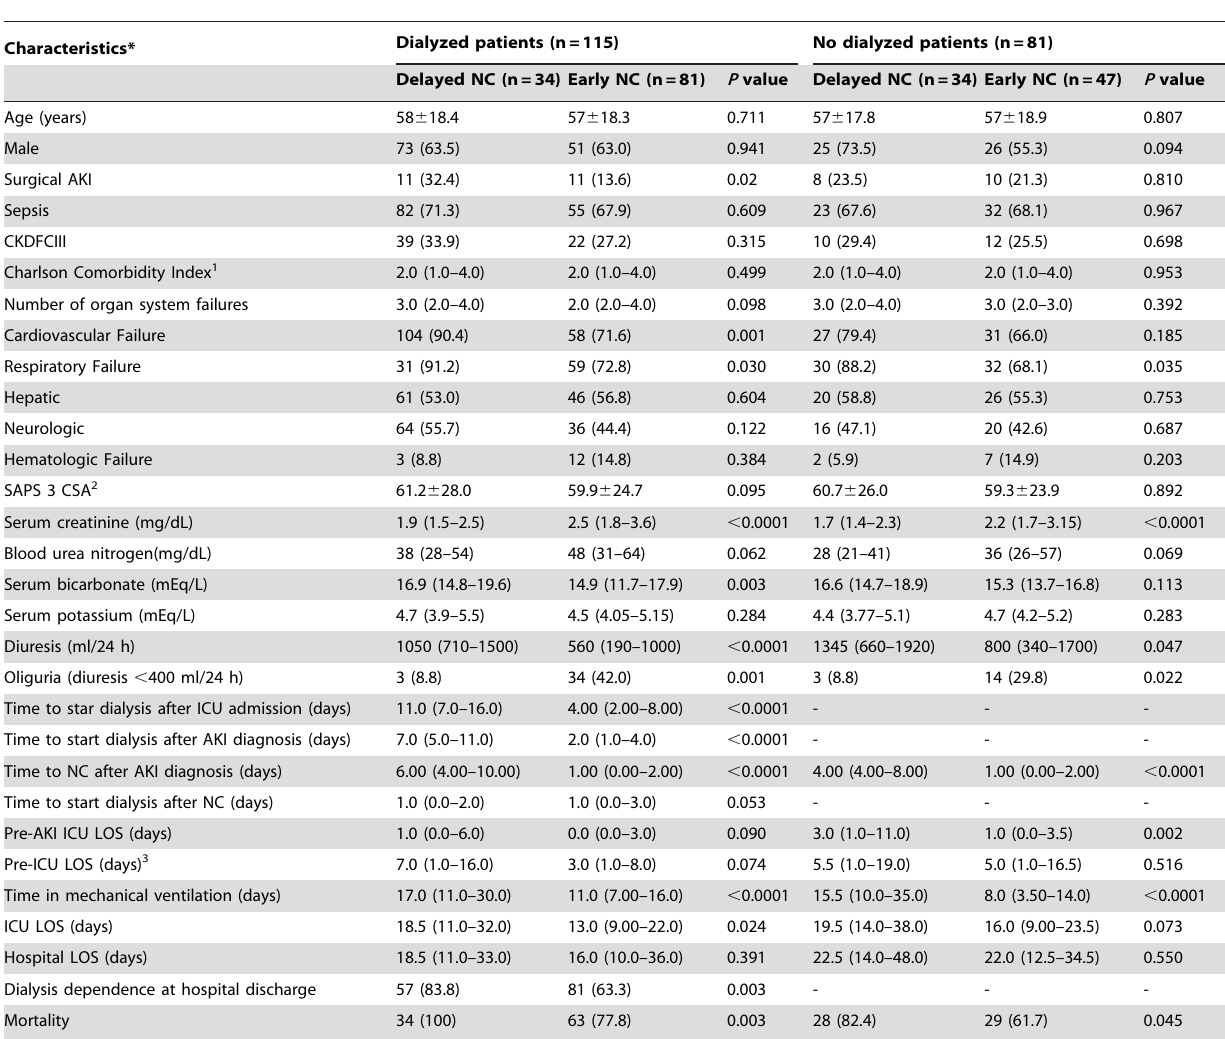
Table 5. Patients characteristics comparing delayed and early Nephrology Consultation (NC) subgroups in both dialyzed and no dialyzed patients on Acute Kidney Injury (AKI) diagnosis